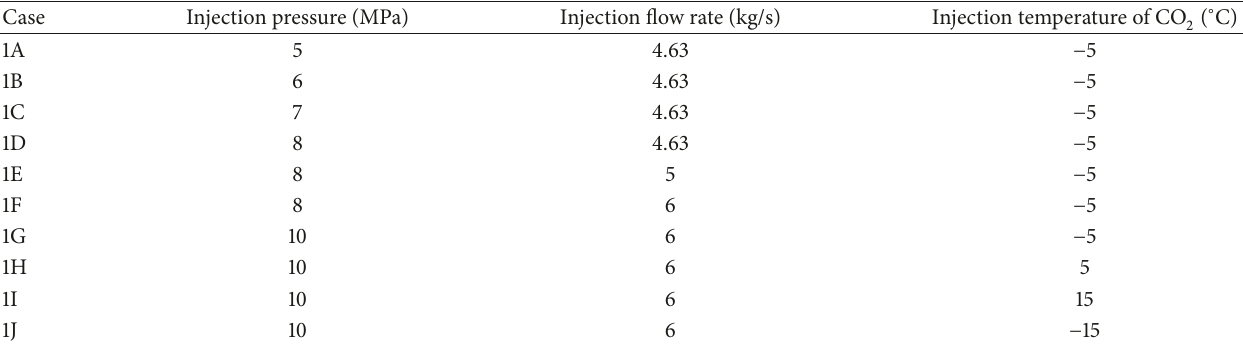
Figure 4: Risk factors of each reservoir which correspond to the different injection parameters at the wellhead of the Shenhua CCS project. (a), (b), and (c) are the results for the different injection pressures, flow rates, and temperatures, respectively. (d) Investigation of the influences of simultaneous changes of the injection pressures and flow rates. Table 2: Injection parameters for the described cases of the Shenhua CCS